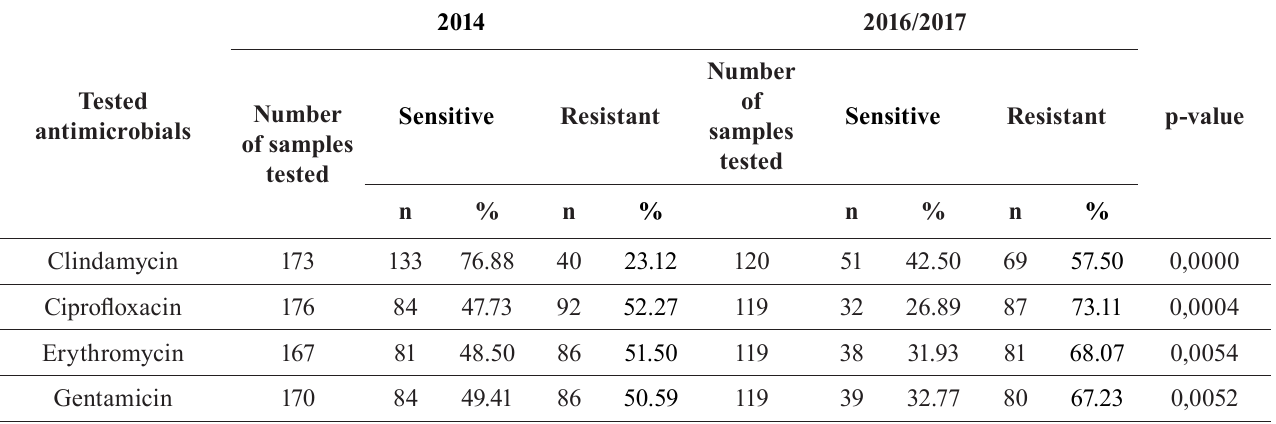
TABLE III – Antimicrobial susceptibility profile of the 176 and 120 coagulase-negative staphylococci (CoNS) samples isolated from blood cultures in 2014 and 2016/2017, respectively, in a tertiary hospital in the southern region of Brazil